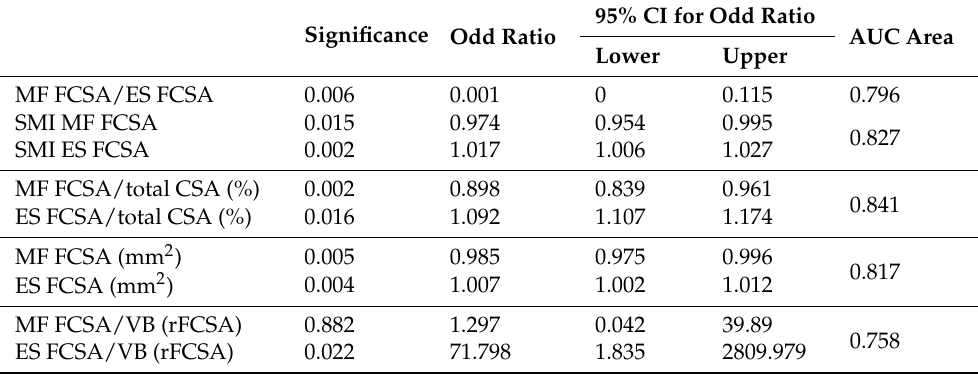
Table 5. Logistic regression analysis: factors associated with the occurrence of degenerative lumbar spondylolisthesis 95% CI for Odd Ratio Significance Odd Ratio AUC Area Lower Upper MF FCSA/ES FCSA